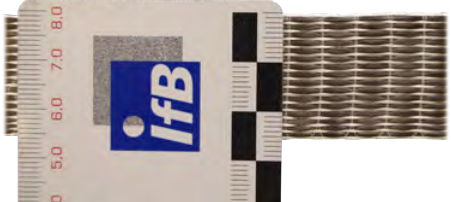
Figure 2. Unidirectional carbon fibre